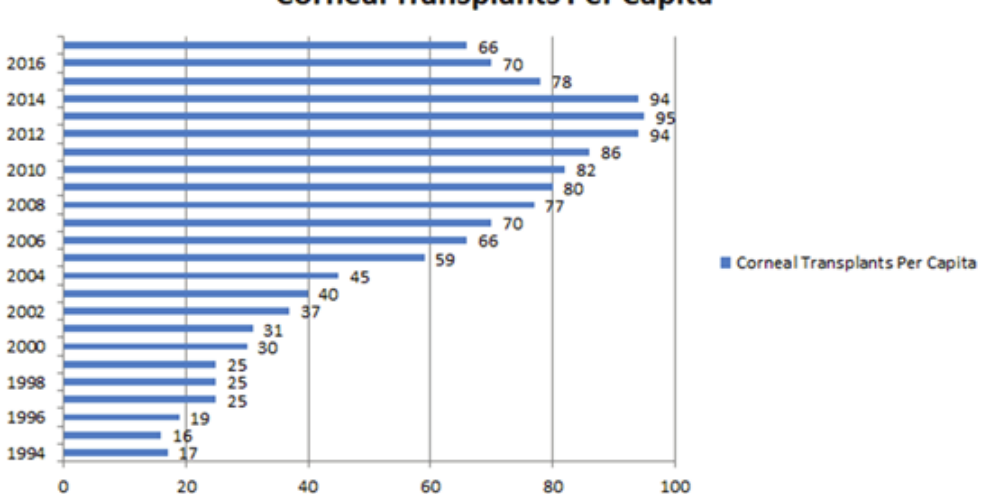
Figure 5. The annual rates of corneal transplants per capita in Iran. Note an increasing rate of corneal transplants per capita from 1994 to 2017, ranging from 16.10 −6 in 1995 to 95.10 −6 in 2013.